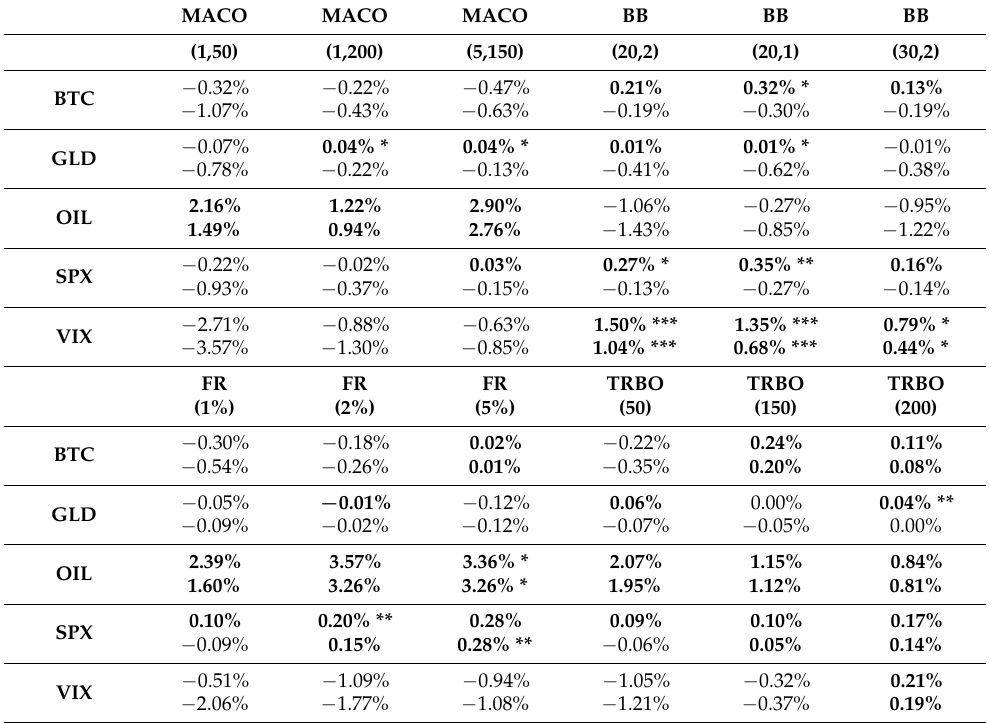
Table 2. TTR Profitability across the full